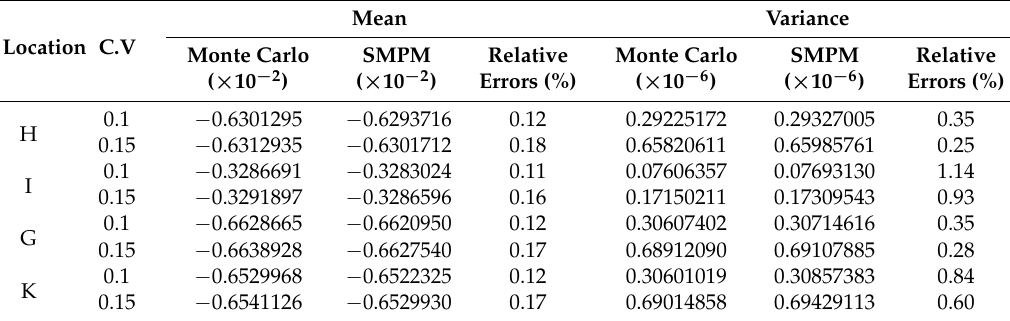
Table 7. The mean and variance of the deviatoric stress S 11 .